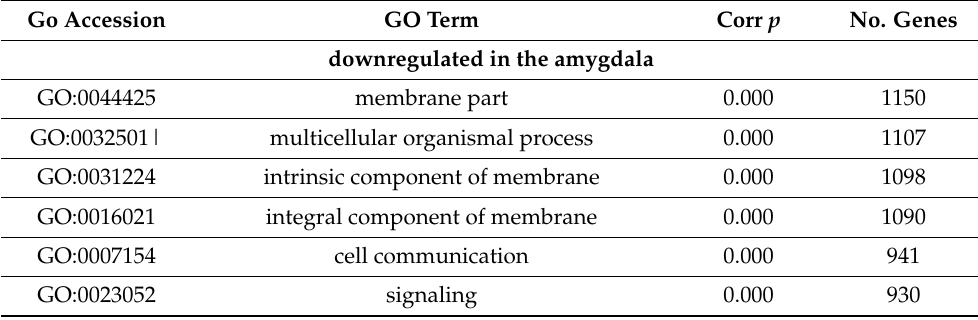
Table 8. Differentially expressed genes enriched in GO terms in stress-exposed rats responding to chronic lithium treatment in comparison to rats before